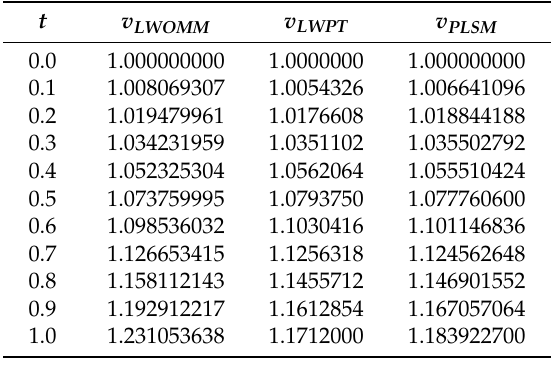
Table 10. Numerical solutions of v ( t ) when α = 0.98 obtained by the introduced method, the LWPT, and the PLSM for Example 5.